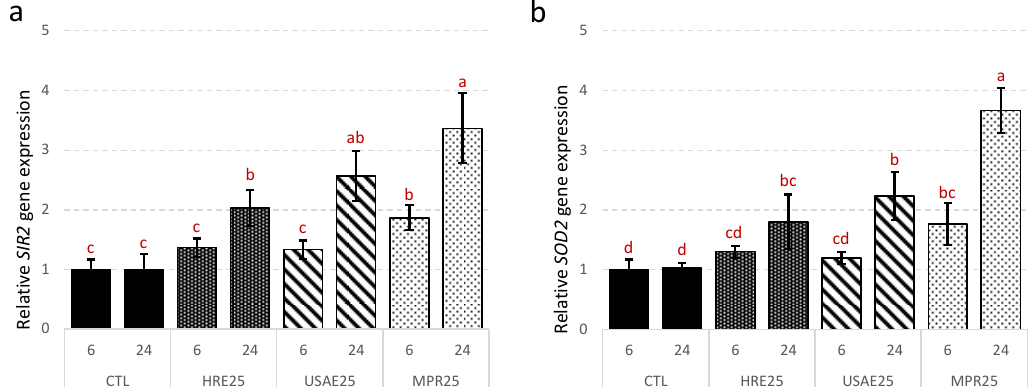
Figure 7. E ff ects of the di ff erent extracts from N. lotus stamen on SIR2 ( a ) and SOD2 ( b ) gene expression determined by RT-qPCR. Expression was normalized with TUB1 gene. CTL are control (untreated, DMSO addition) yeast cells; HRE25 are yeast cells subjected to UV-induced oxidative stress in presence of 25 µ g / mL of N. lotus extract obtained by HRE; UAE are yeast cells subjected to UV-induced oxidative stress in presence of 25 µ g / mL of N. lotus extract obtained by UAE; MPR are yeast cells subjected to UV-induced oxidative stress in presence of 25 µ g / mL of N. lotus extract obtained by UAE followed by DAX-8 MPR purification step. Values are means ± SD of three independent experiments. Di ff erent letters represent significant di ff erences between the various extraction conditions ( p < 0.05).